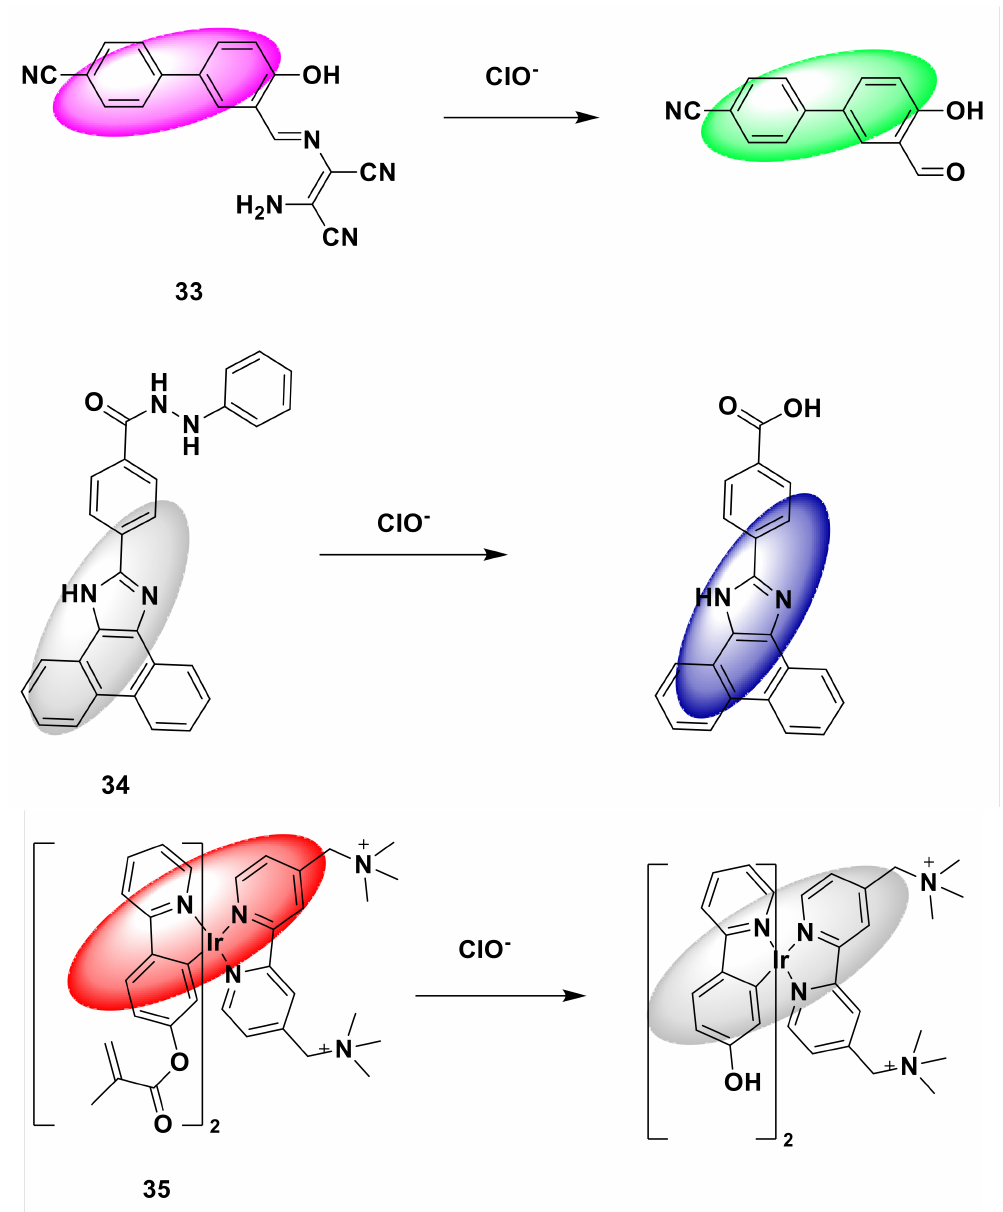
Figure 33. The reactions of probe 33, 34, 35, and ClO −